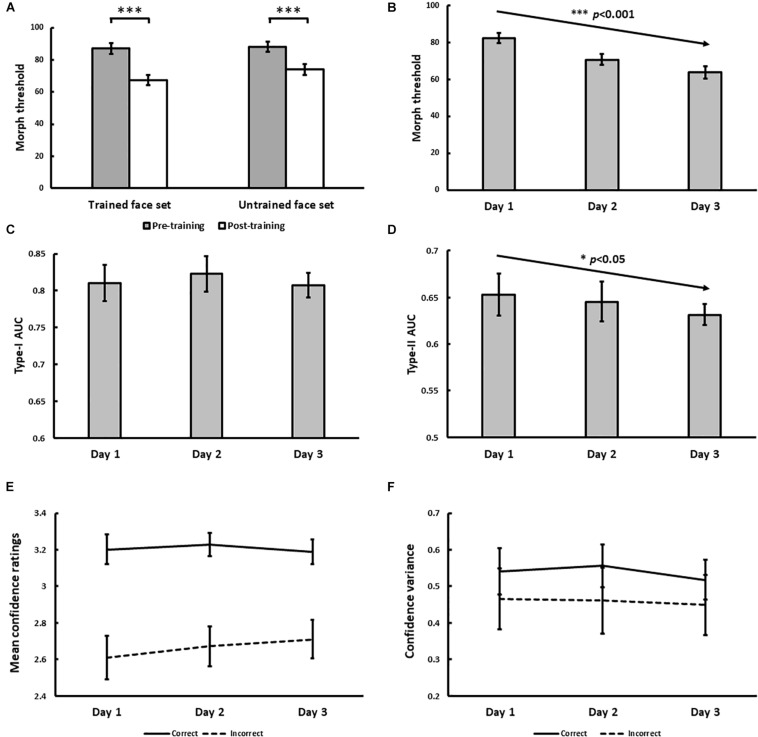
Results for Experiment 1. (A) Pre- and post-training effects measured as median morph threshold for trained and untrained face sets before (on Day 1) and after (on Day 3) training sessions. (∗∗∗ indicates p < 0.001). Threshold significantly decreased with training over 3 days (B), which was accompanied by decreases in Type-II AUC (metacognitive accuracy, p = 0.015; (D) None of the following changed with training: Type-I AUC for objective accuracy (C), confidence ratings for correct (solid) and incorrect (dashed) trials (E), and the variance of confidence ratings for correct (solid) and incorrect (dashed) trials (F). All 5 variables were independently estimated within each training block (see Exp. 1 Method). Error bars denote ± 1 within-subjects SEM (Cousineau, 2005).